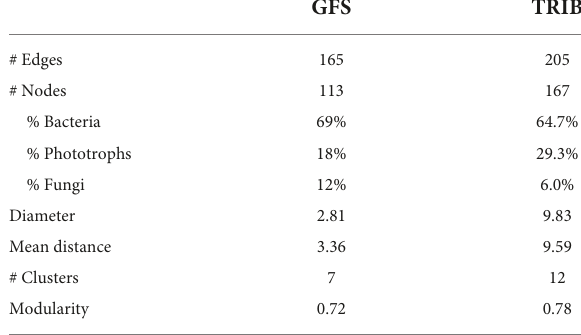
TABLE 3 Co-occurrence network topology